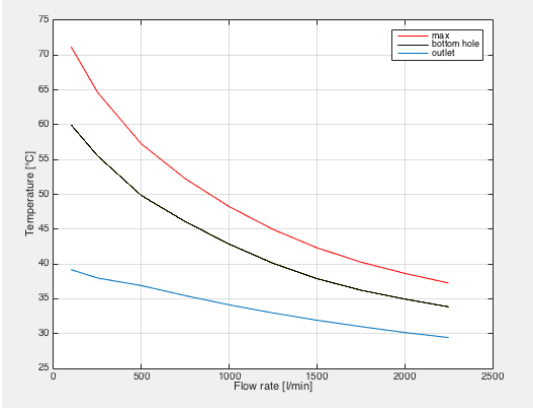
Figure 4: Temperature vs.